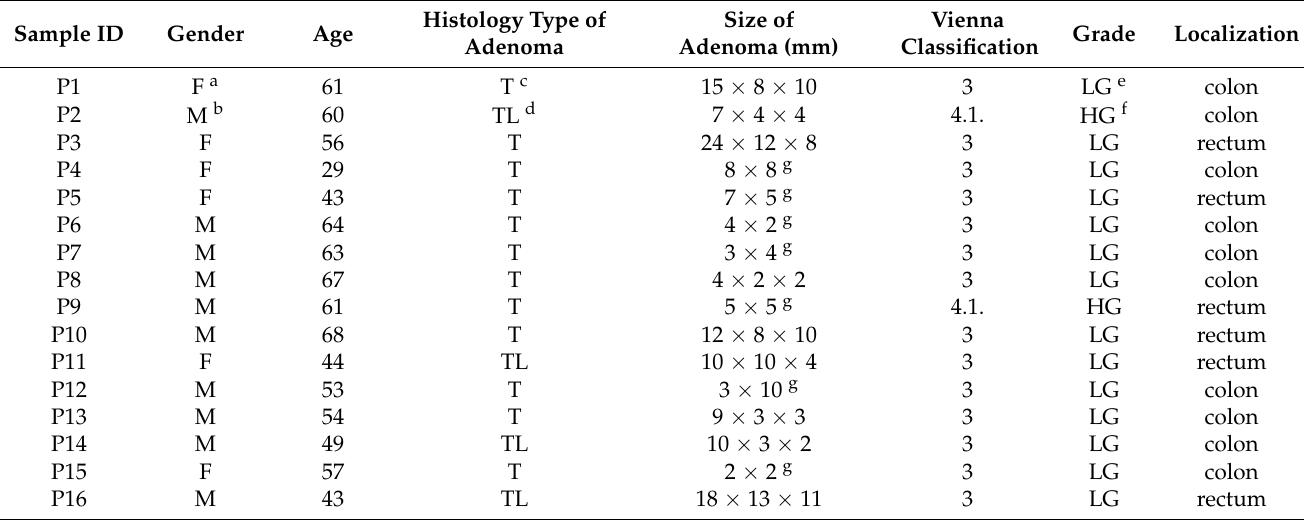
Table 4. Clinical and histological characteristics. a Female, b Male, c Tubular, d Tubulo-villous, e Low grade, f High grade. g For small samples, only two dimensions were given by